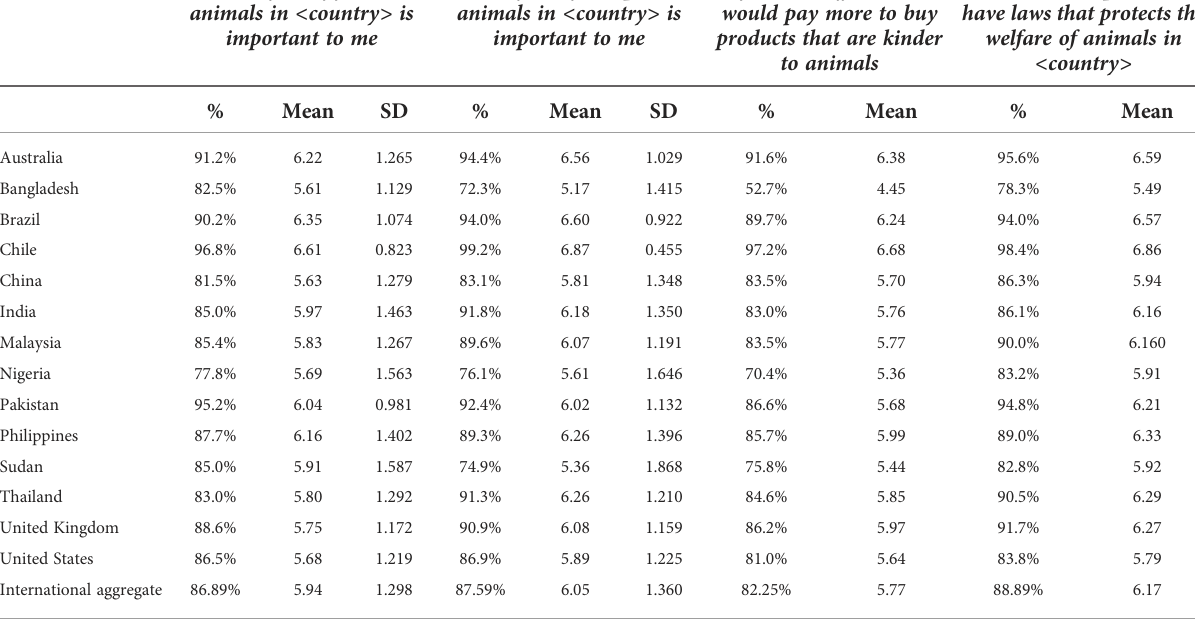
TABLE 2 Means for the level of agreement with animal welfare statements by country, utilizing 7-point Likert scale, and percentage of general agreement with